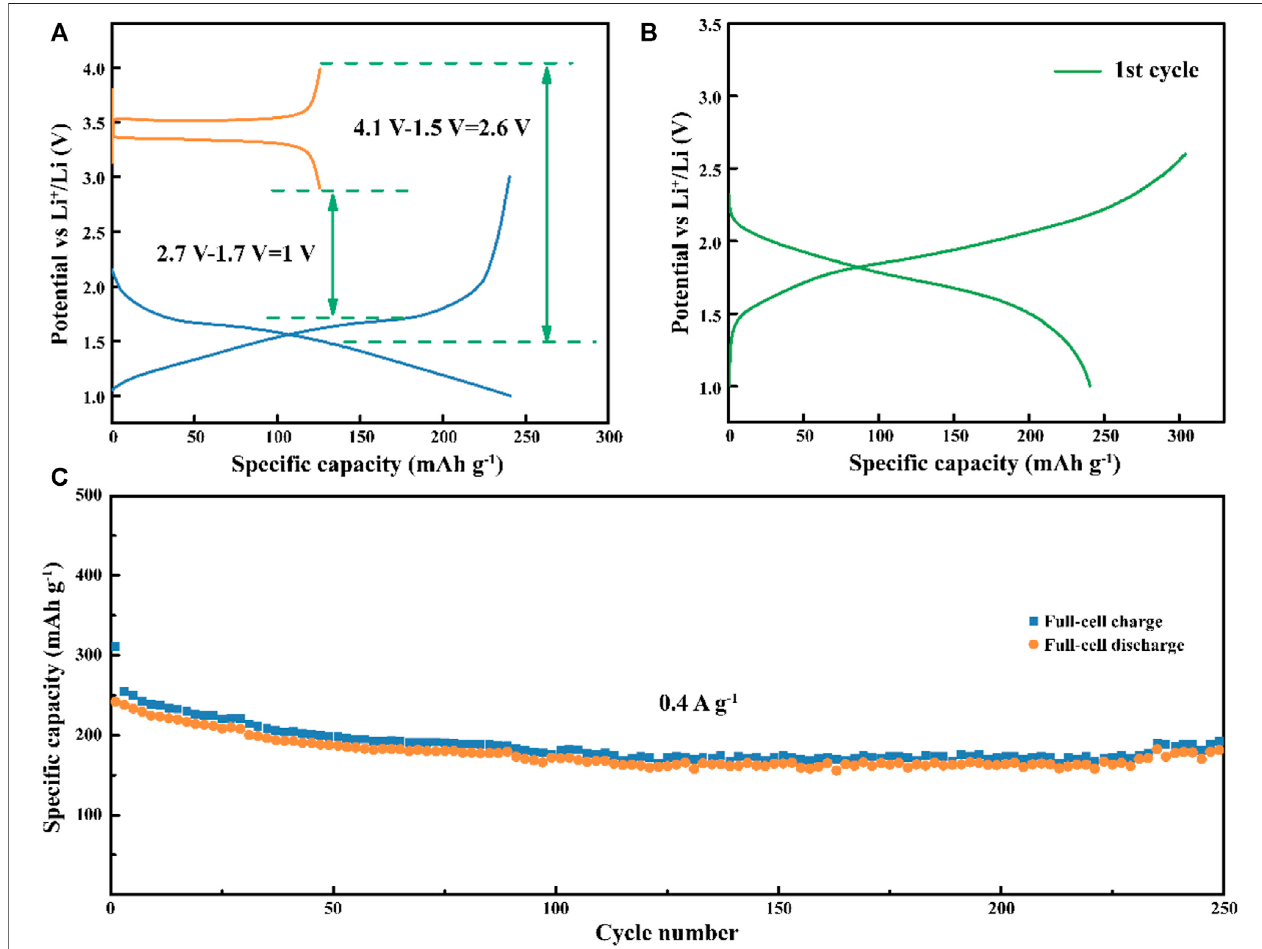
FIGURE 9 | (A) Details of capacity match up in LiFePO 4 //TiNb 2 O 7 full cell; (B) voltage pro fi les of LiFePO 4 //TiNb 2 O 7 full cell; (C) cyclic performance of LiFePO 4 // TiNb 2 O 7 full